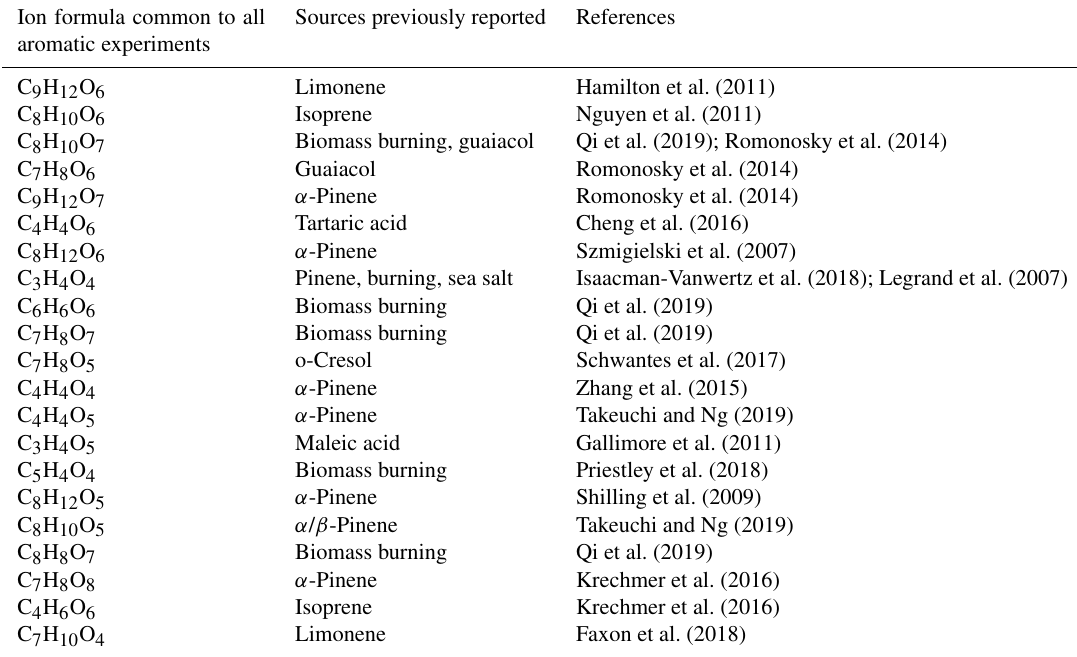
Table 3. Comparison of ions observed commonly from all aromatic precursors with these ions reported in literature. Ion formula common to all aromatic